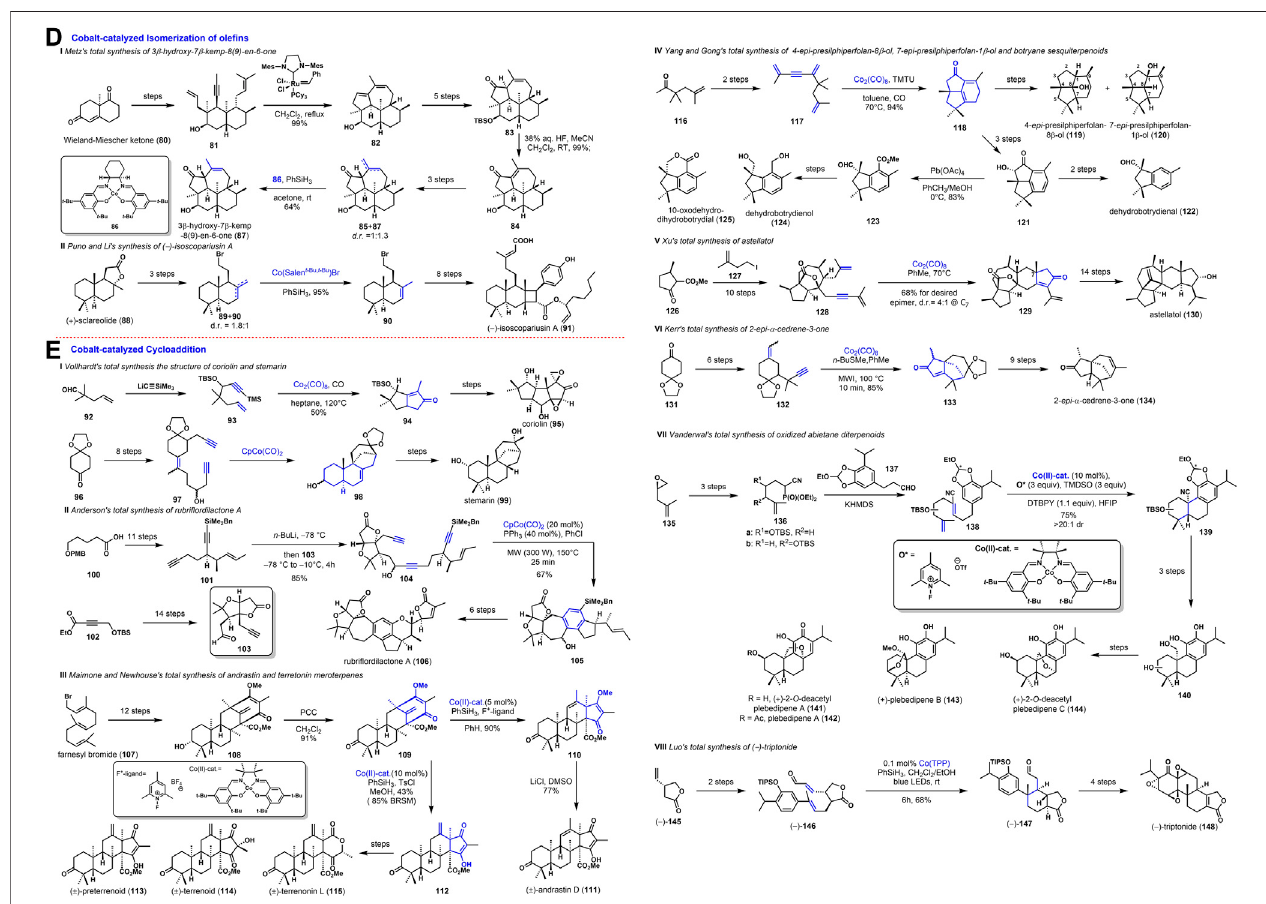
FIGURE 2 | Cobalt-catalyzed Isomerization of ole fi ns, and Cycloaddition.